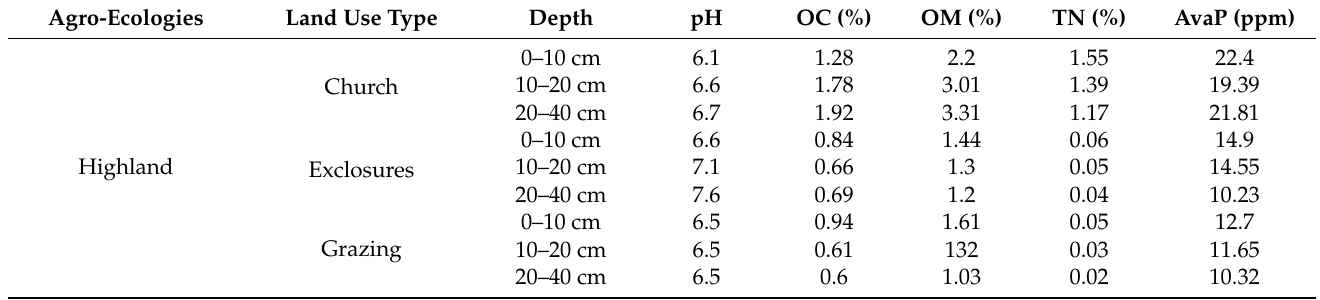
Table A2. Soil chemical properties across different agro-ecologies, land uses, and soil depths.